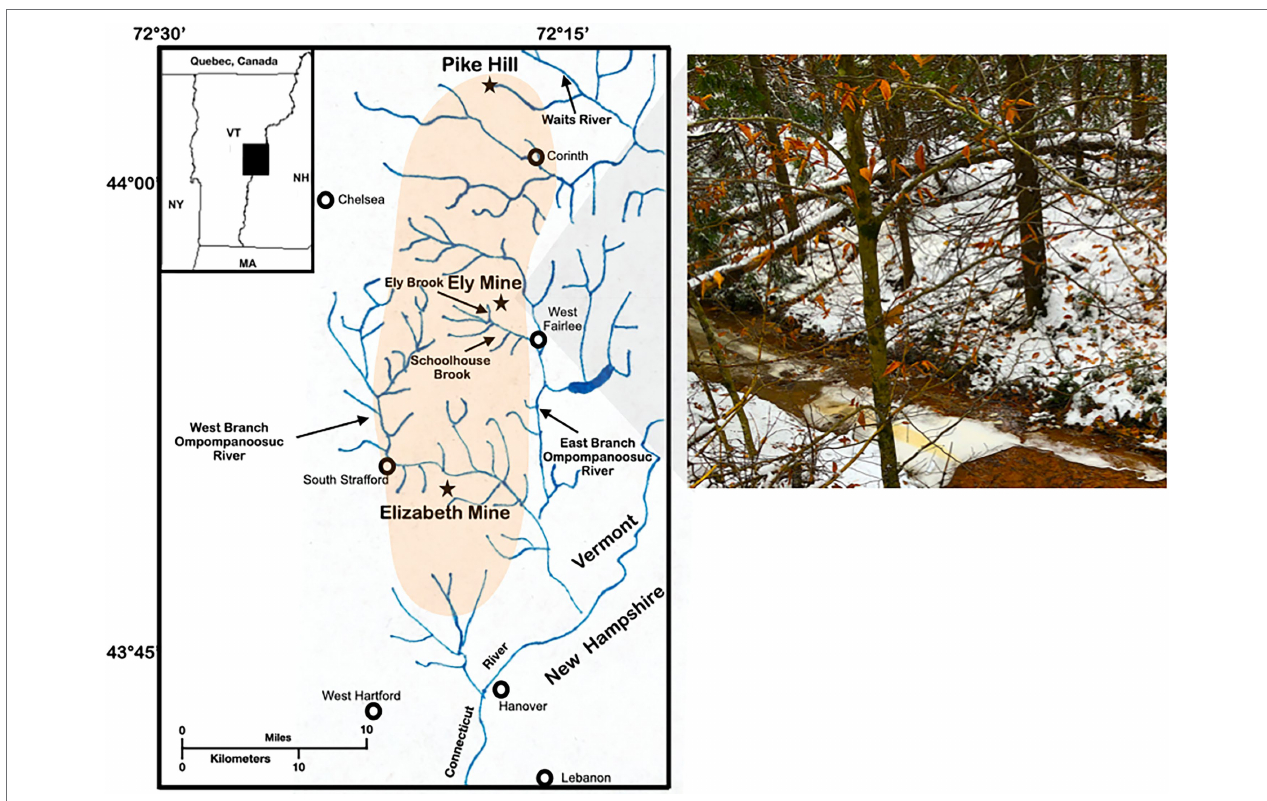
FIGURE 1 | Study site. Map and photograph of Ely Brook (EB-90M) at Ely Copper Mine Superfund site in Vershire, VT on 15 November